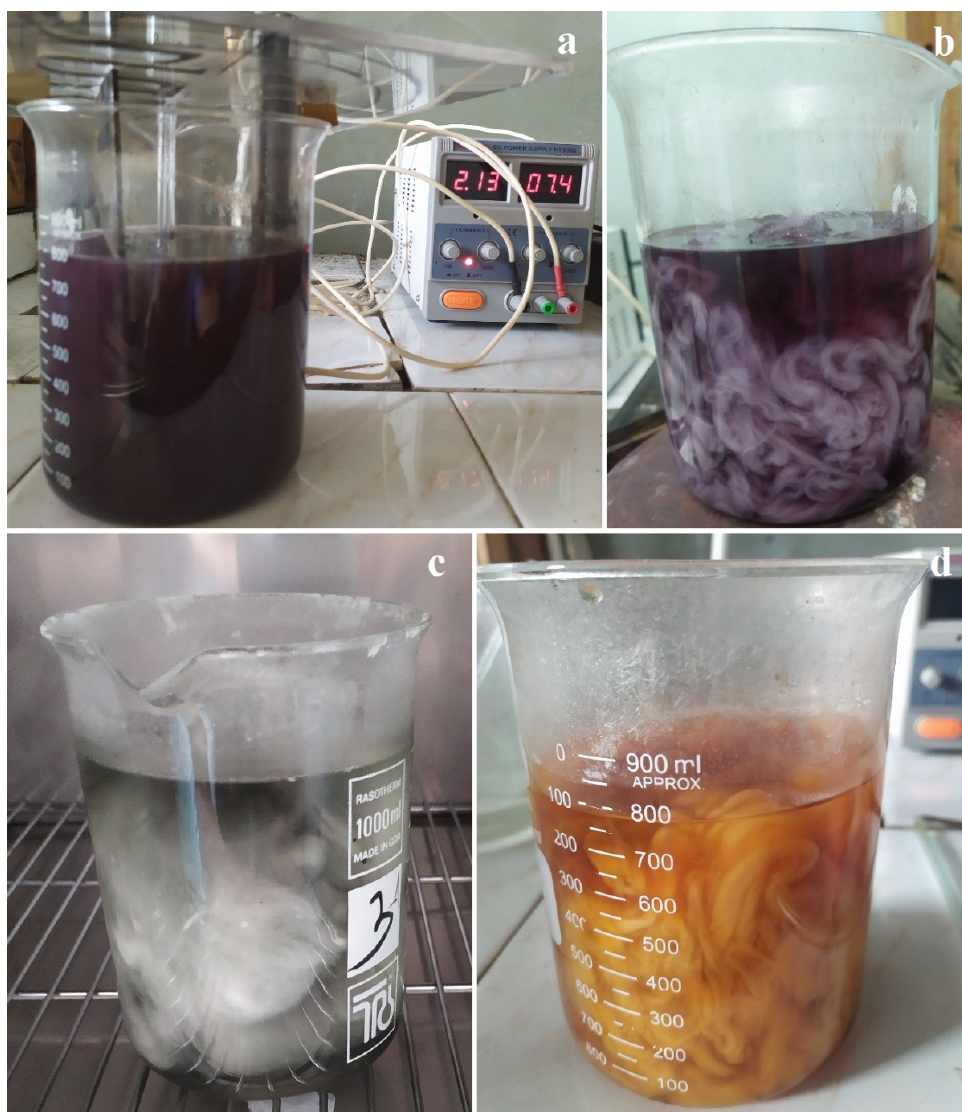
Figure 3. Fe-EGSF fiber production stages: ( a )—electrochemical production of Na 2 FeO 4 ; ( b )—fiber in the initial solution; ( c )—fiber during oxidation; ( d )—the final stage of oxidation.